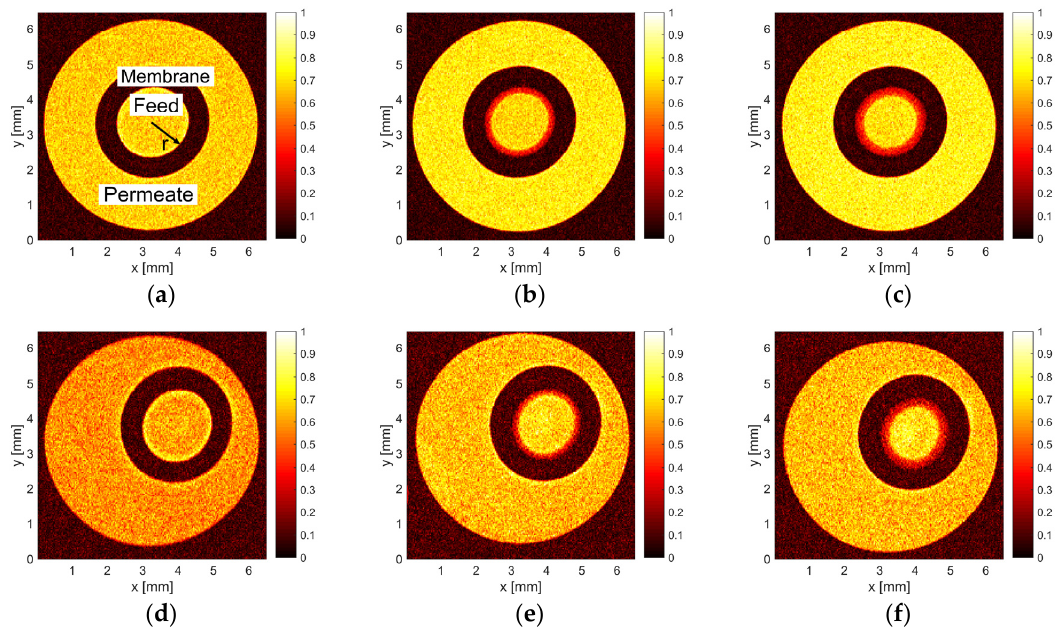
Figure 3. Axial MR images were measured every 5 min at z = 29 cm during dead-end filtration at p = 1.25 bar and different temperatures ϑ = 15 °C ( a )–( c ) and ϑ = 45 °C ( d )–( f ). The normalised MR intensity I / I max is indicated in the false-colour bar. ( a ), ( d ): A reference image of the unused hollow fibre was acquired before each filtration. ( b ): Build-up of the protein deposit at t = 79 min of filtration (red ring at the inner surface of the membranes lumen) and t = 151 min ( c ) for the lowest temperature ϑ = 15 °C. Progressing accumulation of the deposit was observed on the selective layer of the hollow fibre membrane at t = 67 min ( e ) and 168 min ( f ) during the dead-end filtration at ϑ = 45 °C.